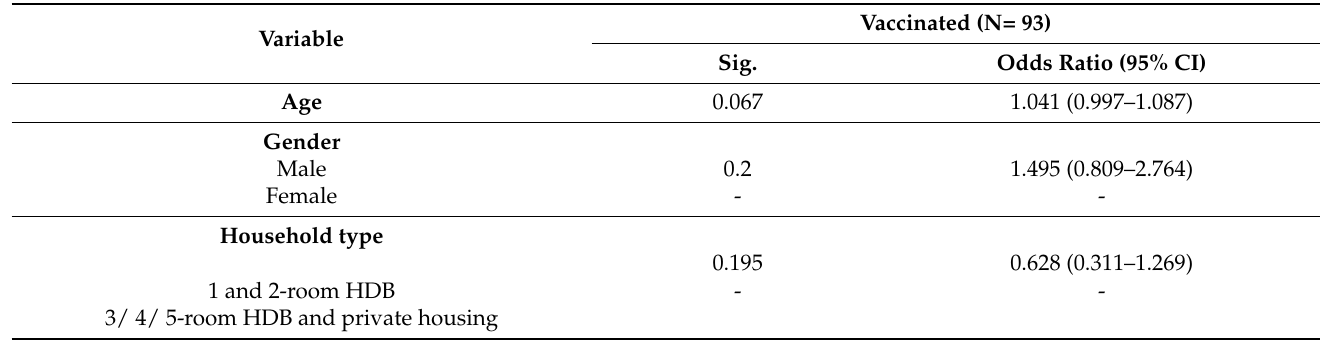
Table 2. Multinomial logistic regression comparing vaccinated (N = 93) and non-vaccinated (N = 114).